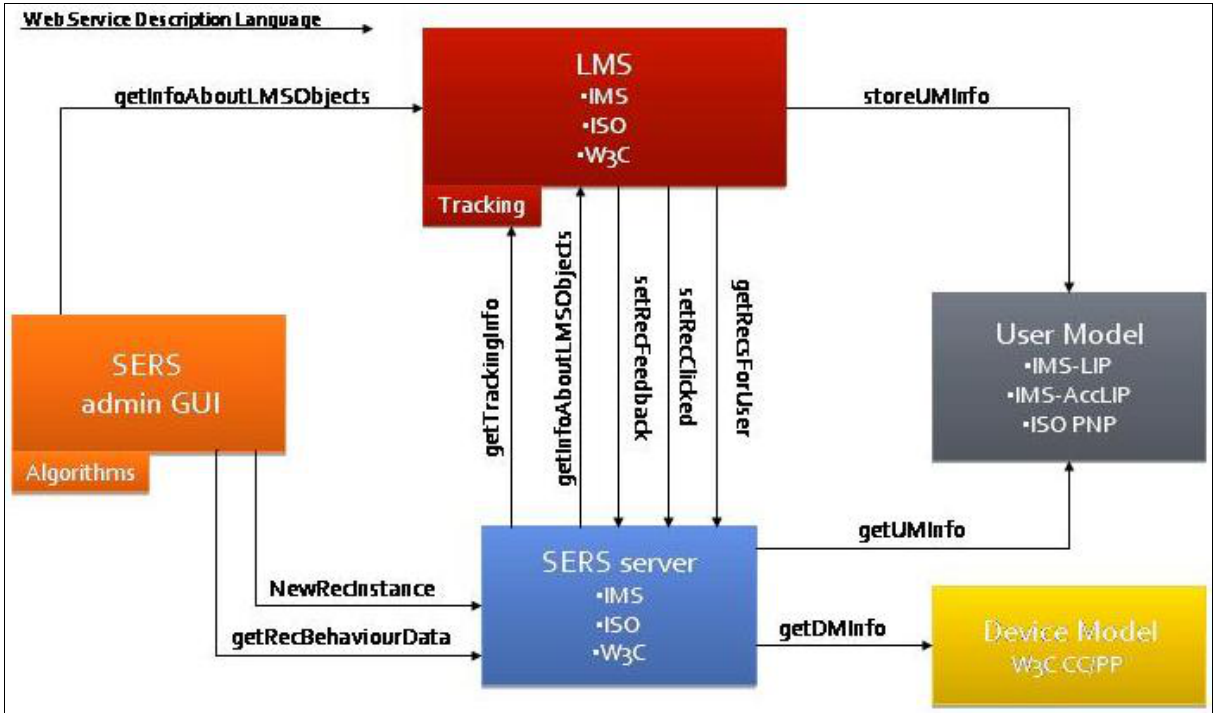
Figure 1. Web services among the SOA components and standards/specifications involved.